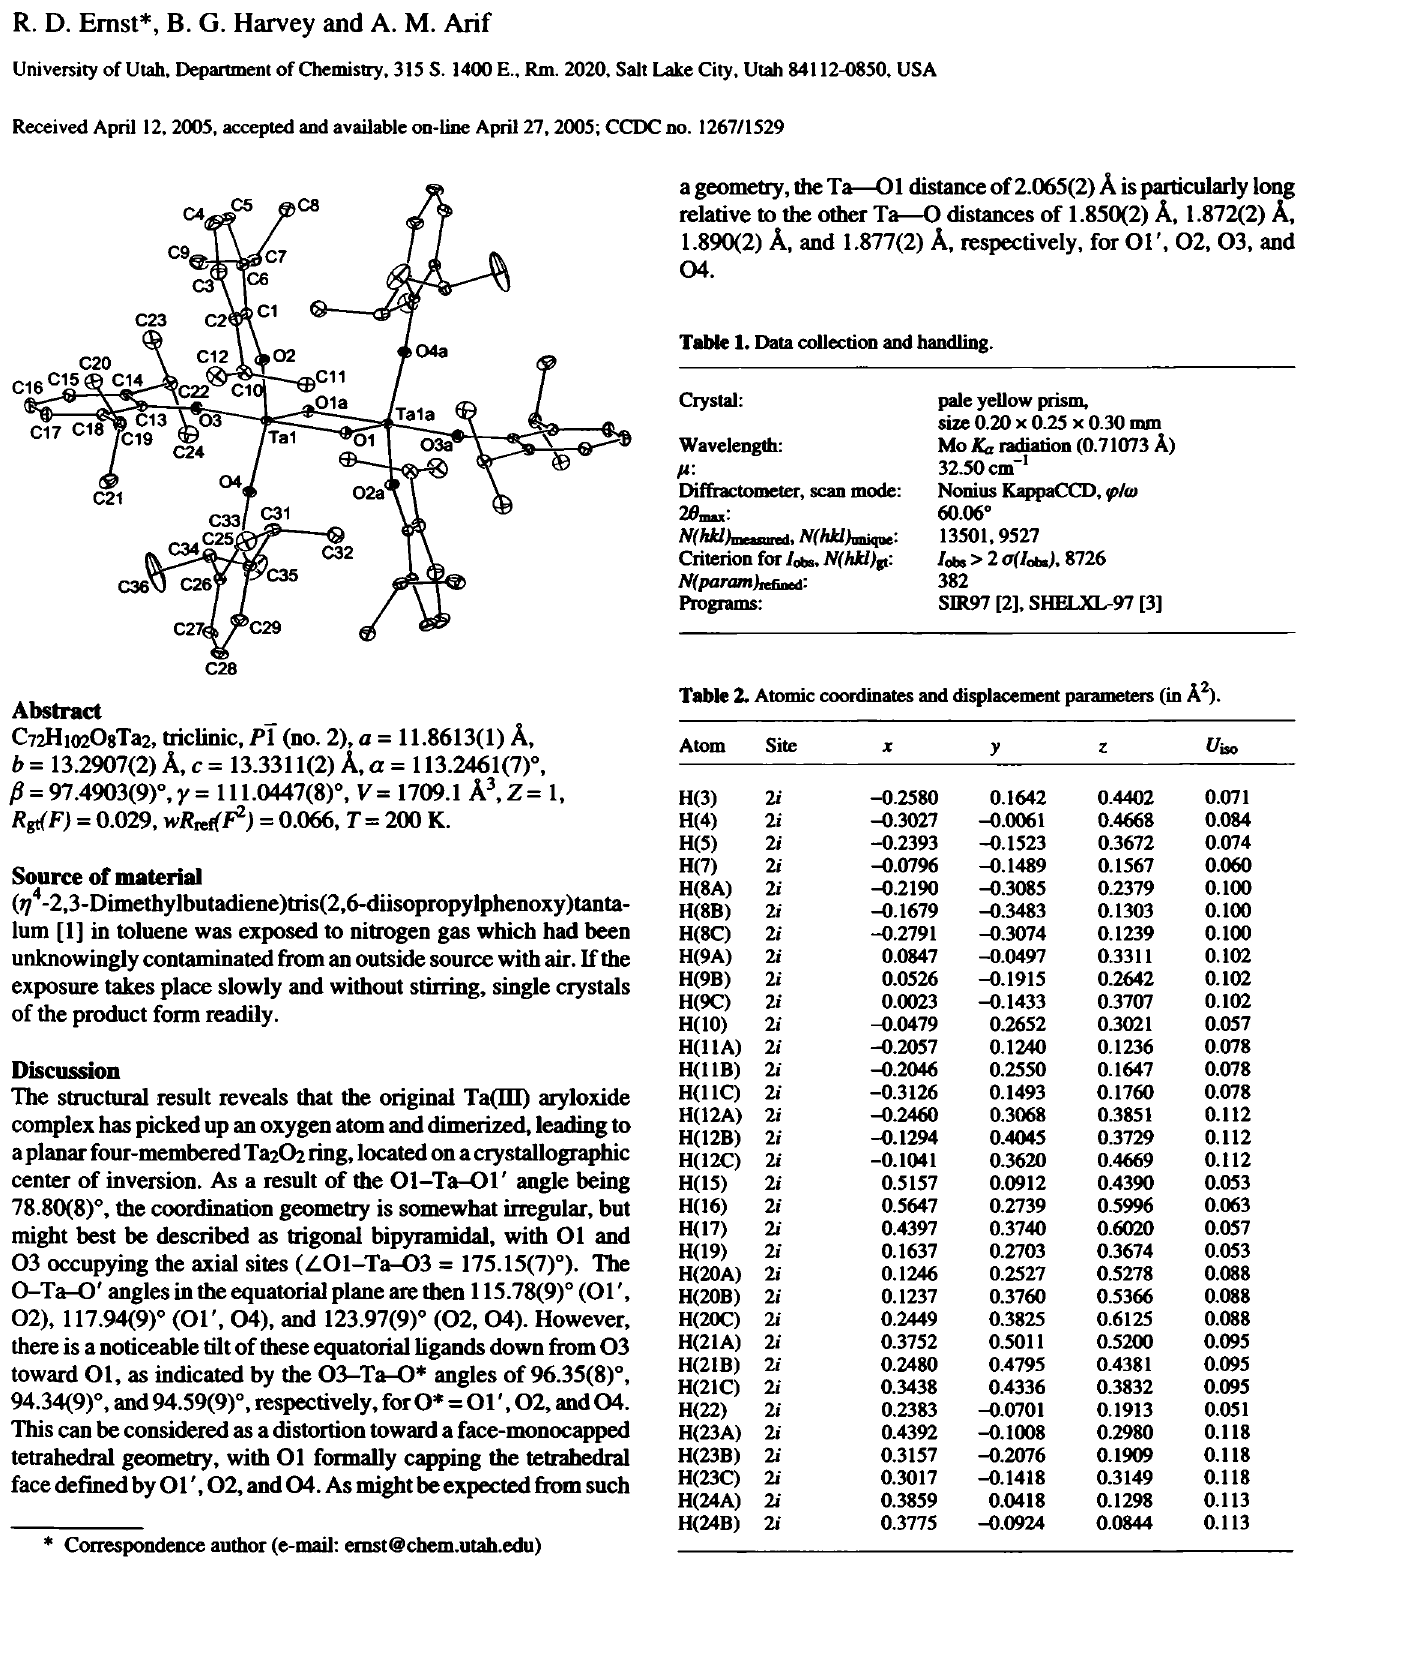
Table 1. Data collection and handling.